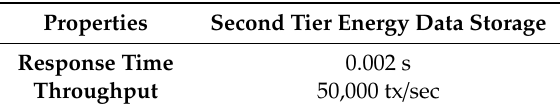
Table 2. Evaluation of the second tier solution throughput.